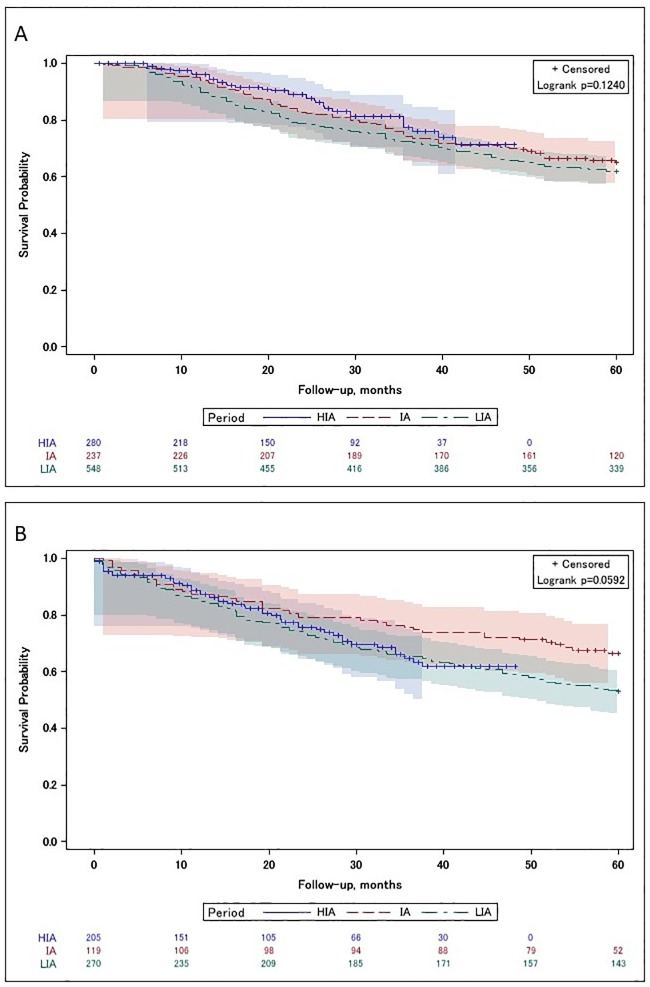
Kaplan–Meier survival curves with number of subjects at risk and 95% Hall–Wellner bands for the (A) No PORT and (B) PORT study population in a N1 situation, related to the treatment periods.IMRT = intensity-modulated radiotherapy, LIA = low IMRT availability period, IA = intermediate IMRT availability period, HIA = high IMRT availability period.